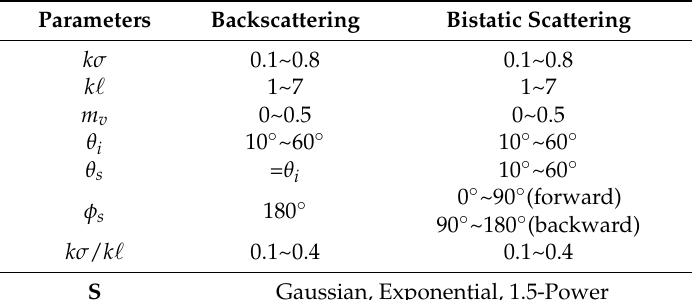
Table 3. Radar parameters for generating training samples.